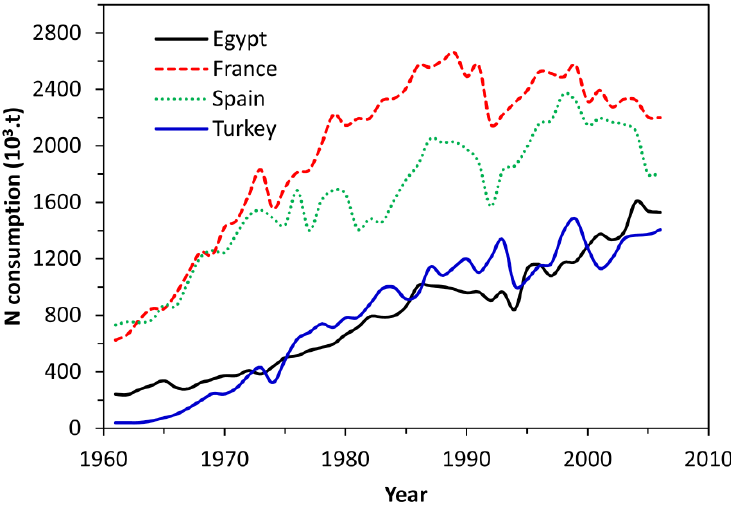
Figure 1. Temporal evolution of total nitrogen (N) consumption in four Mediterranean countries. It is shown that in all countries, important interannual variations in N consumption may occur (see Section 2.1 for more